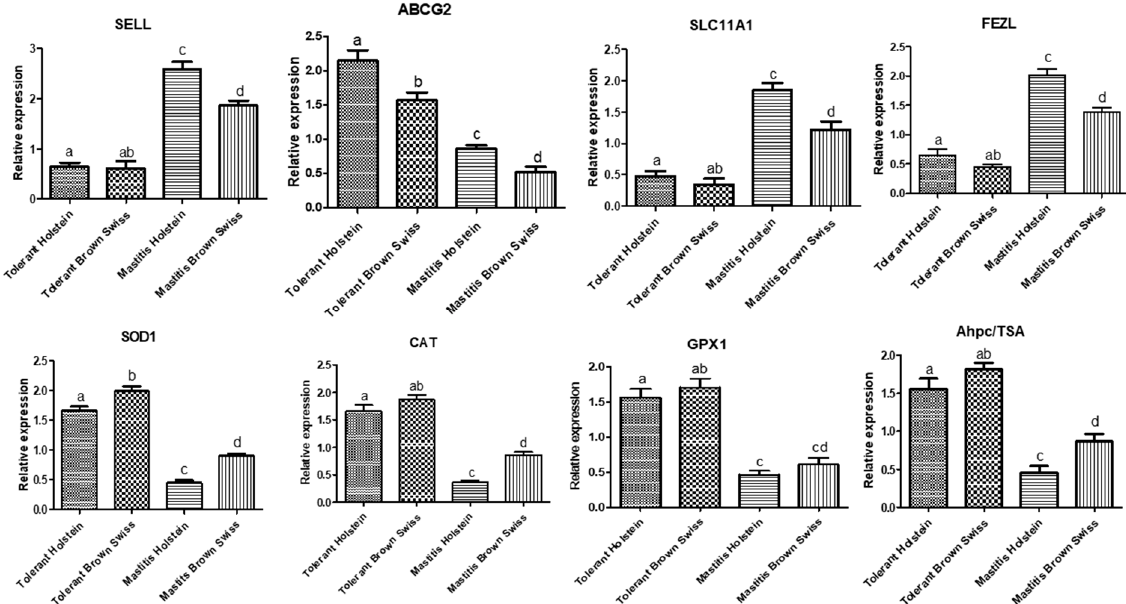
Figure 1. Relative expression patterns of SELL , ABCG2 , SLC11A1 , FEZL , SOD1 , CAT , GPX1 , and AhpC/TSA genes in the tolerant and mastitis-affected Holstein and Brown Swiss dairy cows. a, b, c, d, ab, cd means small alphabetic letters show significance when p < 0.05.